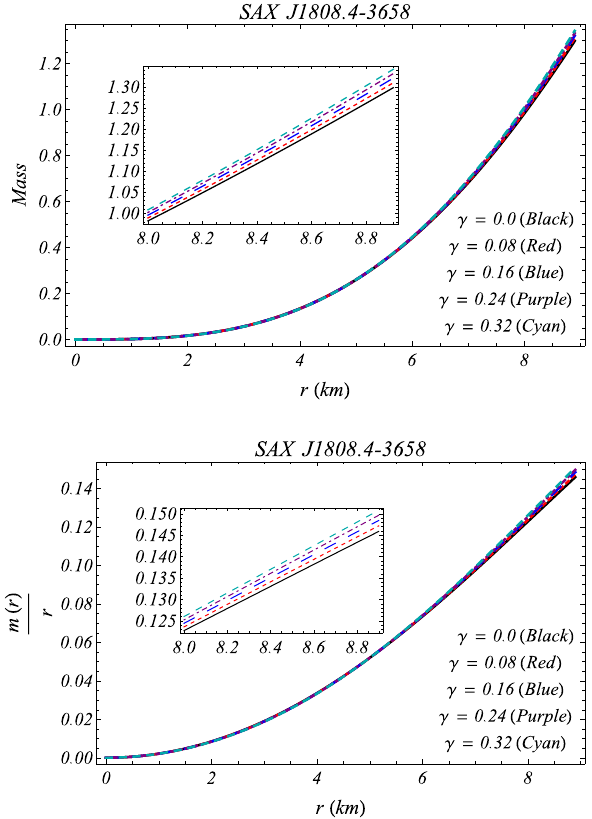
Fig. 6 The variation of mass function and compactness against the radius for different values of γ mentioned in the